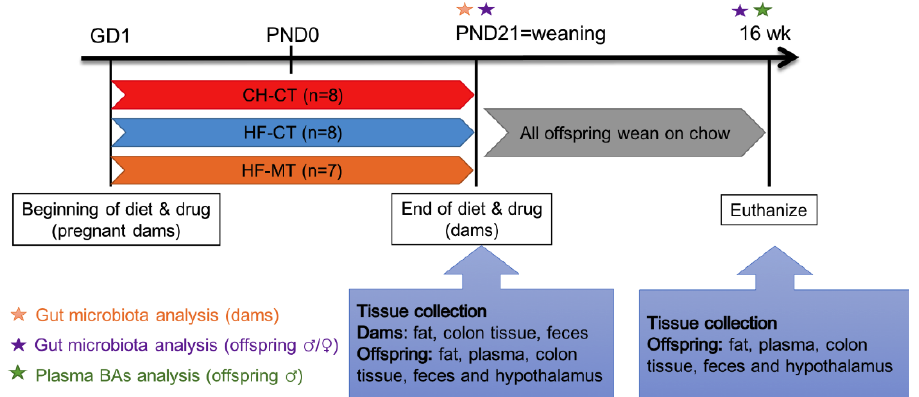
Figure 1. Schematic of maternal diet and drug regimens and tissue collection time points. Dams were fed a chow (CH) or high ‐ fat (HF) diet and given water (CT) or metformin (MT) throughout gestation and lactation. Offspring were all weaned on a chow diet and given water without metformin. Tissues, plasma and colonic contents were collected at postnatal day (PND) 21 and 16 weeks of age separately.